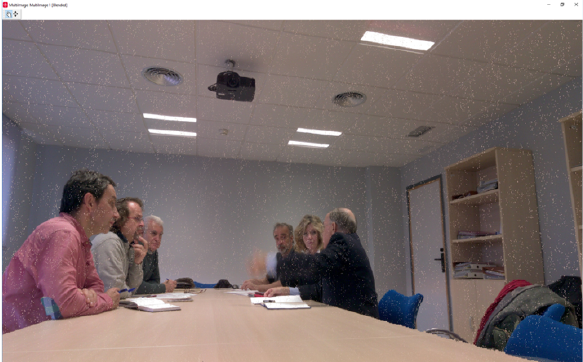
Figure 5. HDR image of a hospital’s meeting room, captured by the Leica BLK360 scanner.